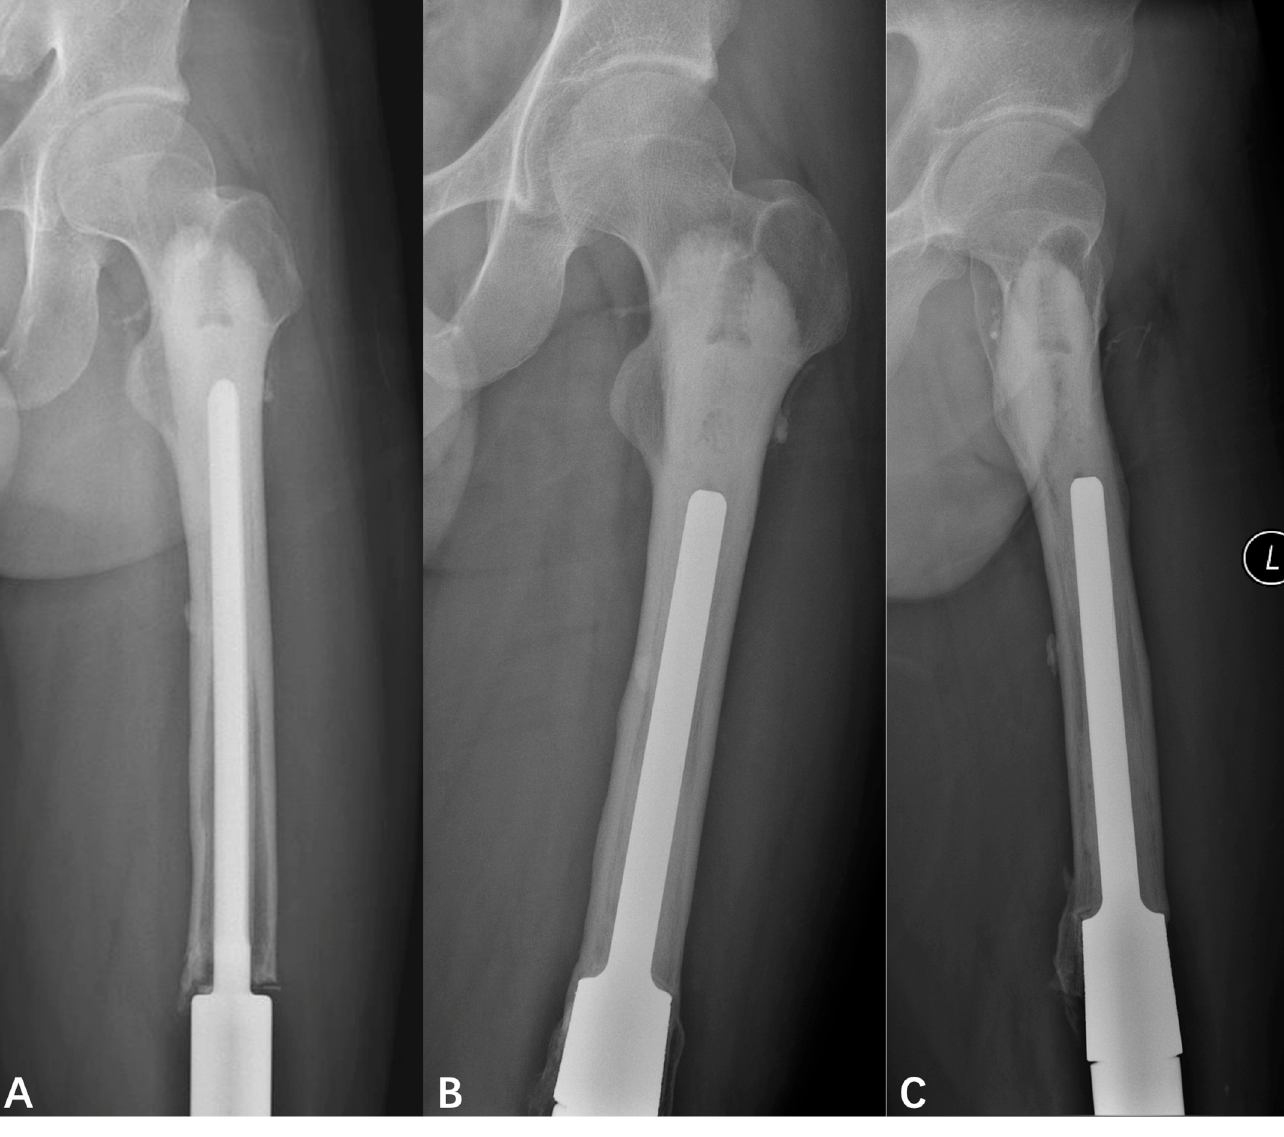
Figure 4. ( A ) AP radiographs of a 17-year-old man showed aseptic loosening at 75 months follow-up after prosthesis replacement. ( B ) The AP radiographs at 78-month follow-up post-revision showed no aseptic loosening and extracortical bone ingrowth in both the medial and the lateral aspects. ( C ) The lateral radiographs at 78-month follow-up post-revision showed no aseptic loosening and extracortical bone ingrowth in the posterior aspects but not the anterior aspect.